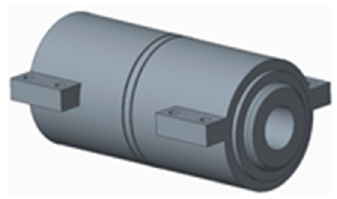
Figure 11. Hoverboard articulation.